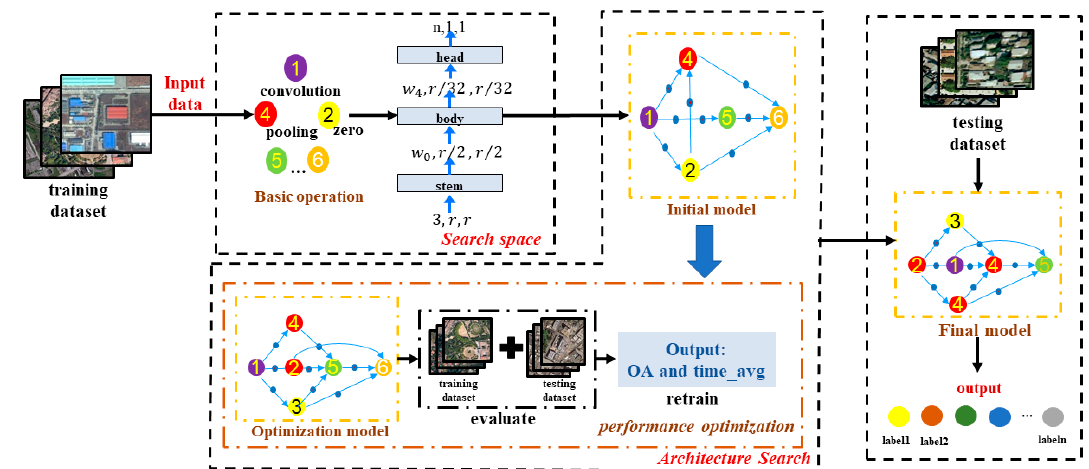
Figure 5. Cross-domain scene classification process based on the SGNAS.